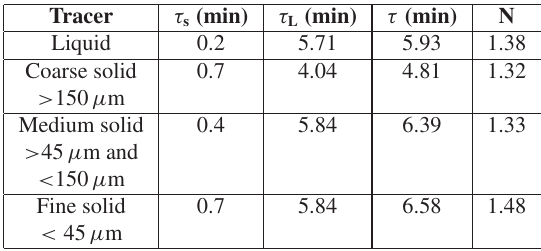
Figure 9. Normalized activity response and adjusted models for liquid tracer in cell tailings. Table 1. LSTS and N tanks in series model